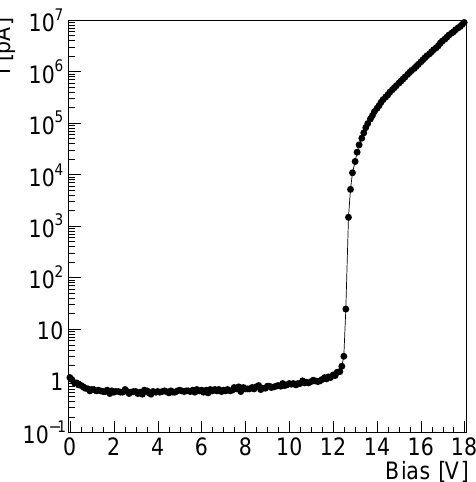
Figure 3. Current–voltage characterization of the SiPM microcell in dark